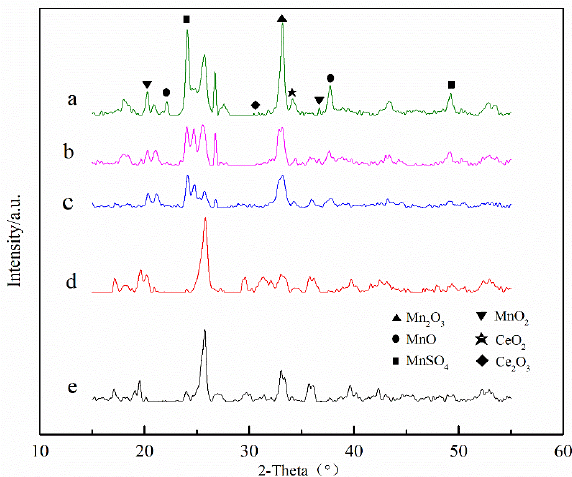
Figure 3. XRD experimental results of different catalysts. ( a ) Ce 0.0 -Mn/AC; ( b ) Ce 0.2 -Mn/AC; ( c ) Ce 0.4 - Mn/AC; ( d ) Ce 0.8 -Mn/AC; ( e ) Ce 1.0 -Mn/AC. ( c ) Ce 0.4 -Mn/AC; ( d ) Ce 0.8 -Mn/AC; ( e ) Ce 1.0